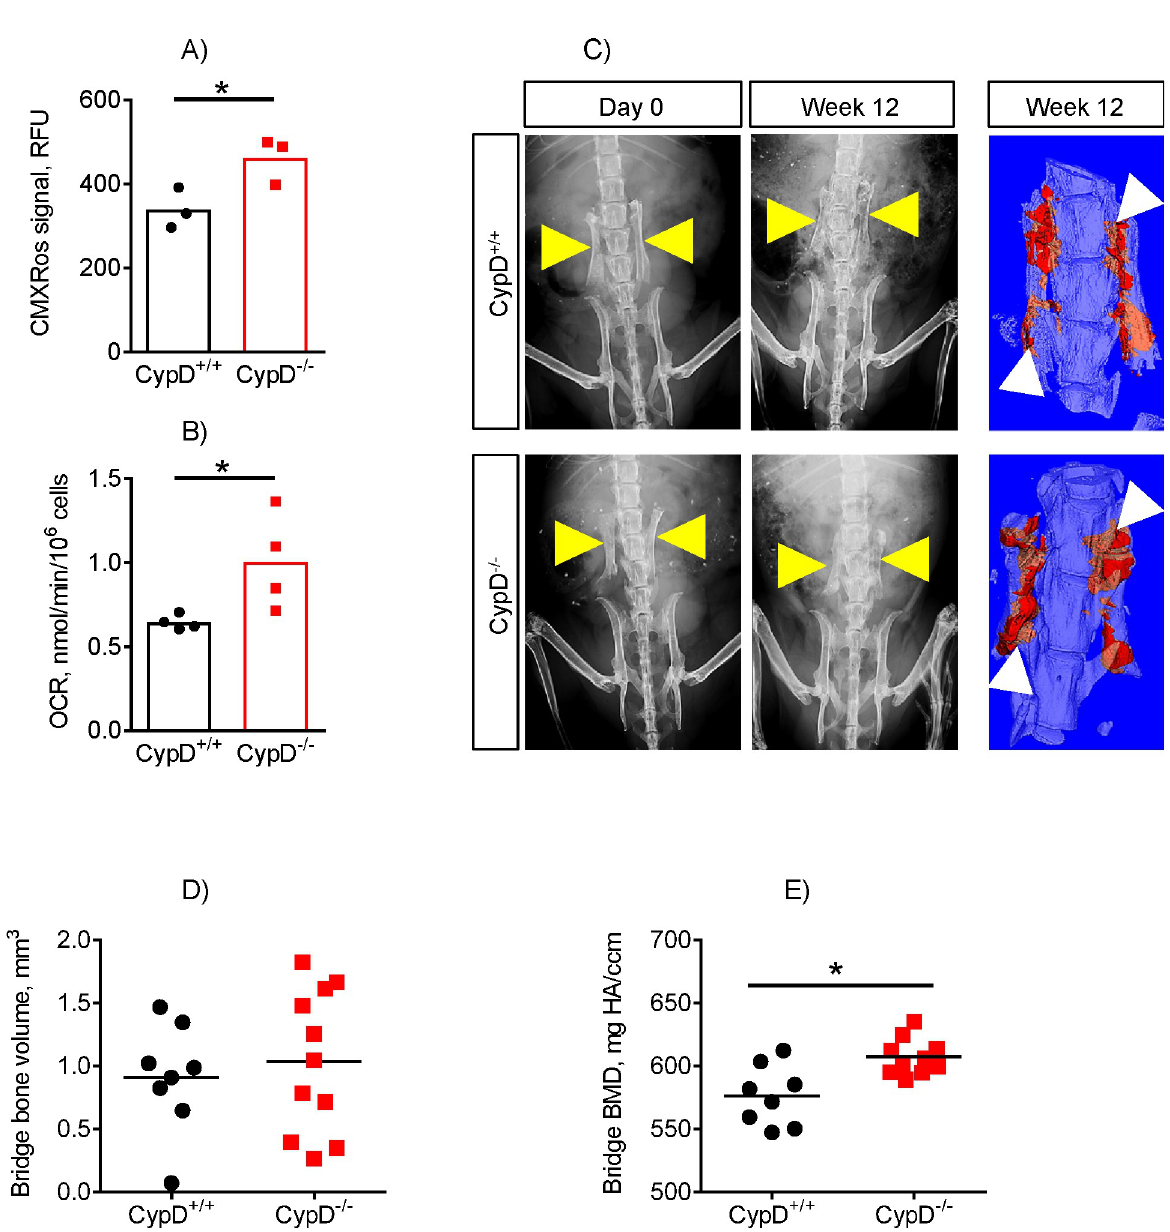
Fig 4. Mice with higher oxidative metabolism show better mineralization of spinal fusion grafts. A) When compared to their control (CypD +/ + ) littermates, BMSCs from CypD -/- mice have higher oxidative metabolism measured with both CMXRos (A) and via oxygen consumption rate (OCR) assay using Seahorse XF technology (B); C) X-ray and micro-CT images of spinal grafts at D0 and at 12 wks post-surgery. Yellow arrowheads indicate grafts on X-ray and white arrowheads indicate newly formed bone (colored red) in micro-CT scans. Newly formed bone volume (D) and bone mineral density (BMD, E) were derived from micro-CT analysis of new bone formation at the fusion site. Plots show actual data points and calculated Means. � , p < 0.05 ( t -test).